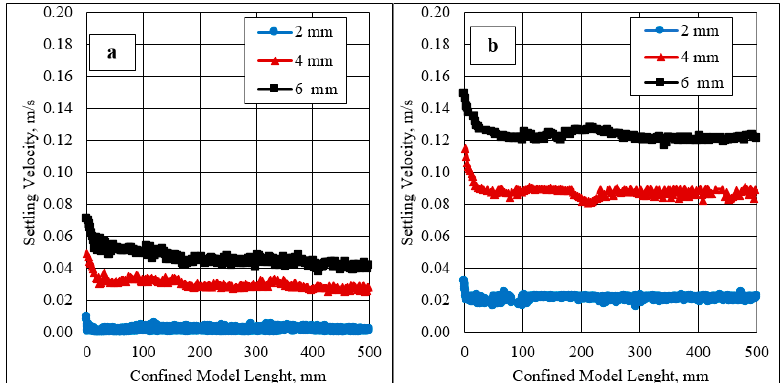
Figure 16. Terminal settling velocity of spherical particles using ( a ) single particle and ( b ) multi particles.